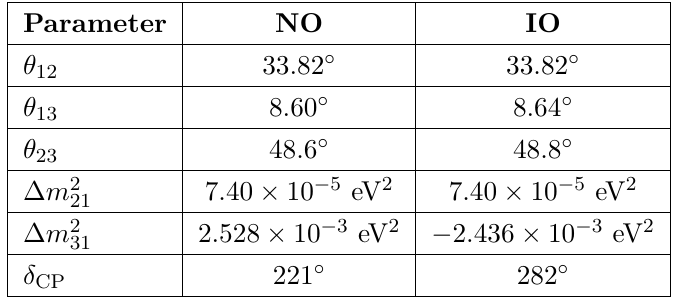
Table 2. List of the three-flavor oscillation parameters from NuFit 4.1 [1] (July 2019) for NO and IO including Super-Kamiokande data. These values are used to generate the observed Asimov datasets ( N dat ). ij